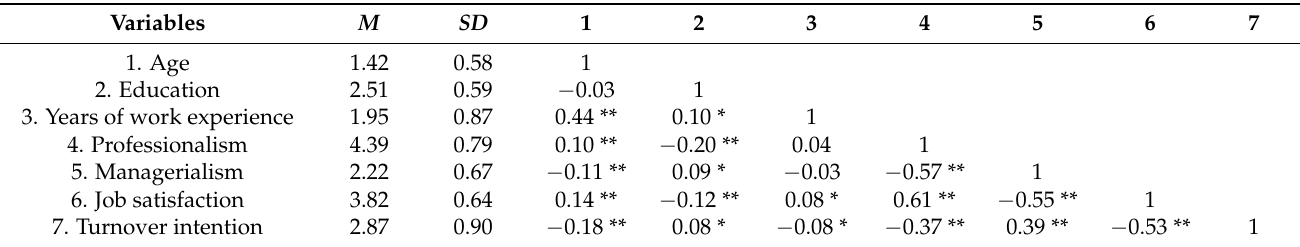
Table 2. Results of descriptive statistics and correlation analysis for each variable ( n =